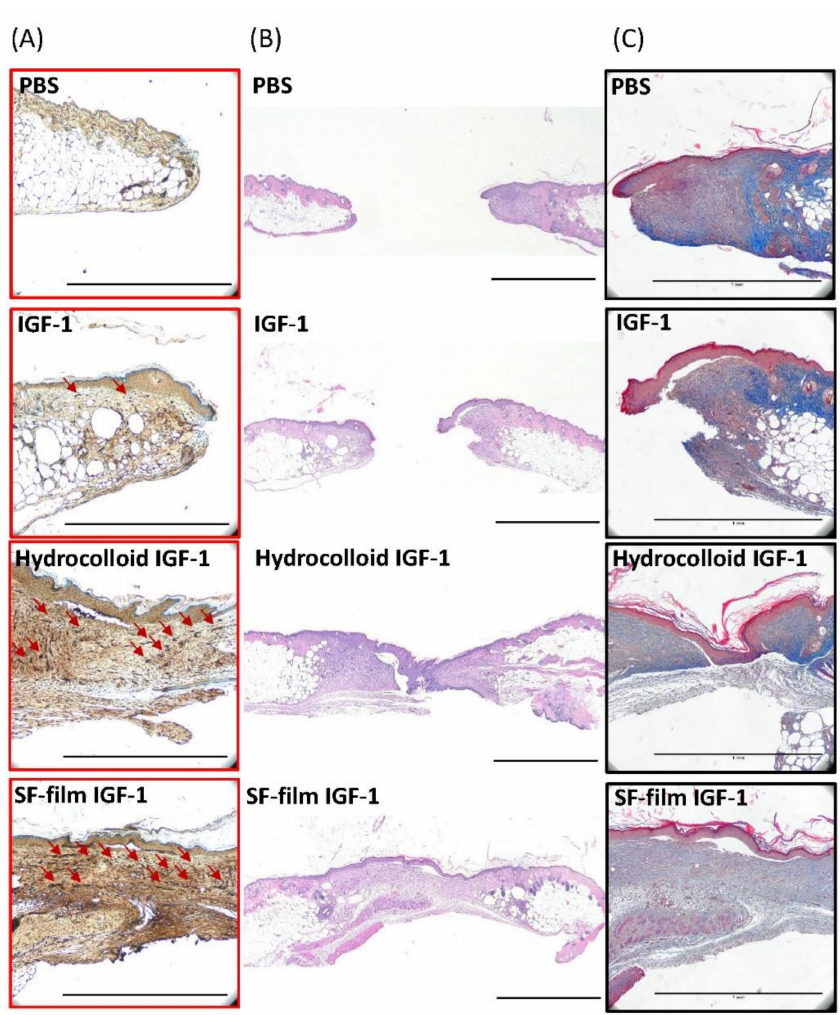
Figure 5. Sections of regenerative tissue in the wound area following treatment with PBS (control), native insulin-like growth factor 1 (IGF-1), a commercial dressing product (hydrocolloid IGF-1), and insulin-like growth factor 1-loaded silk fibroin films (SF film IGF-1) 13 days post-wounding. ( A ) Immunohistological sections of regenerative tissue were stained with an anti-human CD31 antibody. The presence of blood vessels is indicated by red arrows, ( B ) Hematoxylin and Eosin (H&E) stain, and ( C ) Masson’s trichrome stain (black frame). (Scale bars = 1 mm). As results have previously shown, the wound edge and epithelial gap in db / db mice administered with IGF-1-loaded SF films were improved by 13.2% and 23.0%, respec- tively, both of which were smaller than PBS control mice for the same skin repair period (Figure 6A,B). Furthermore, IGF-1-loaded SF films displayed a significantly higher cell proliferation activity, by approximately six times higher than the PBS control group in the granulation tissue area (Figure 6C). The highest re-epithelization was shown in SF film IGF-1 treatments (Figure 6D), while the epithelial tissue in the hydrocolloid IGF-1 group was clearly thicker than the PBS control group (Figure 6E). For all treatments, no significant differences were observed in the adipose tissue gap (Figure